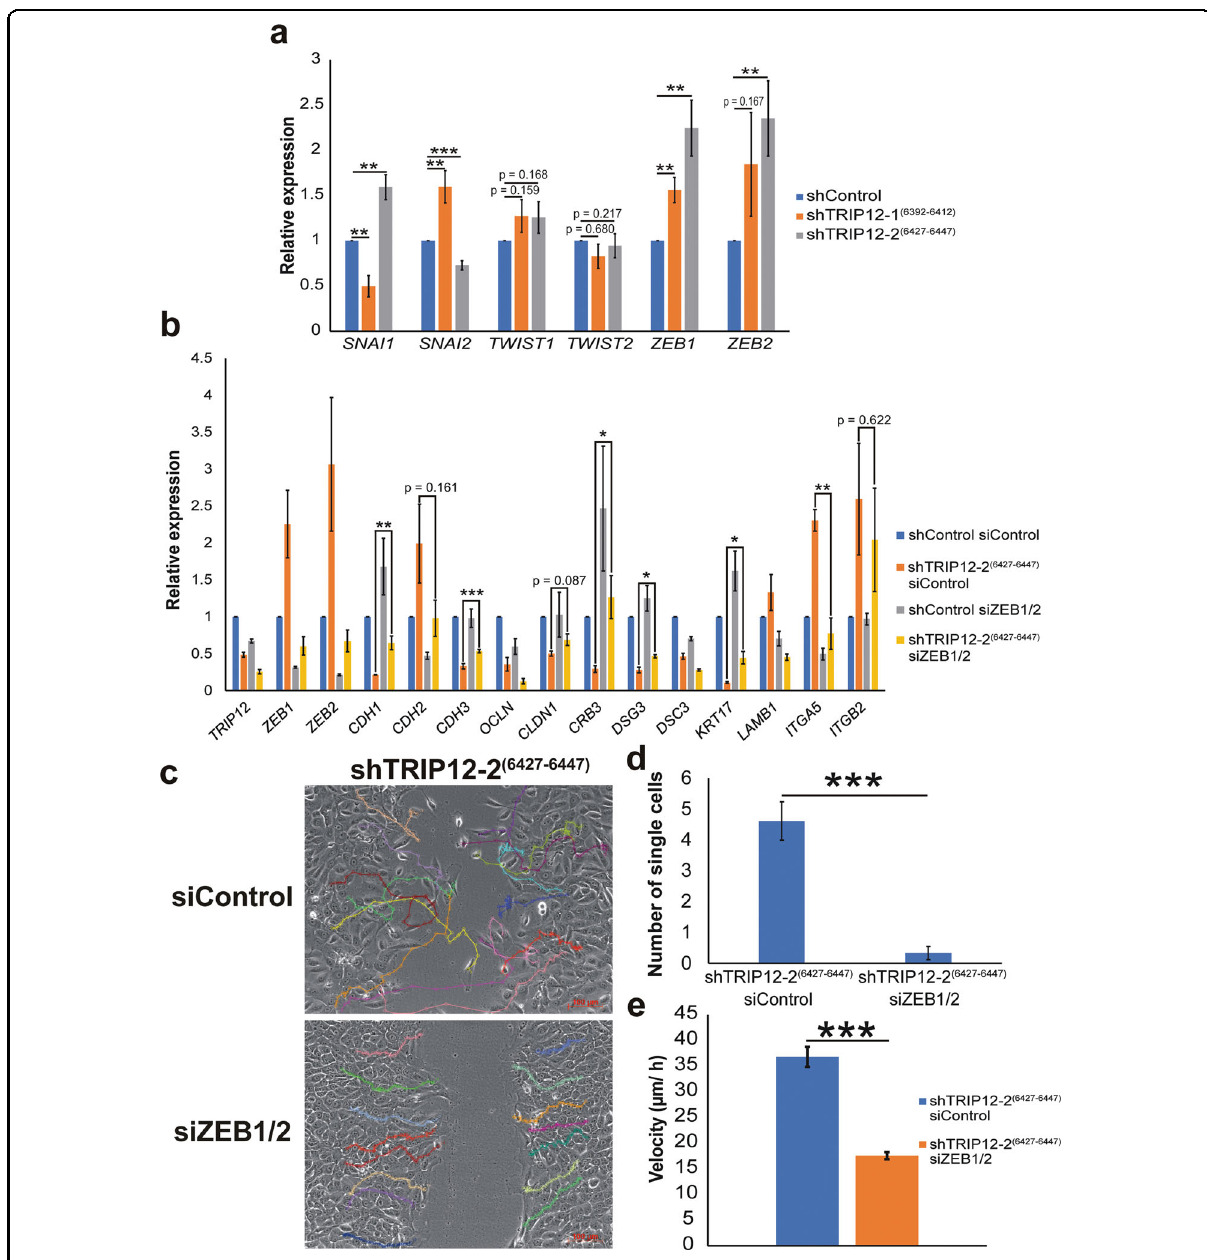
Fig. 5 TRIP12 inhibits ZEB1/2 gene expression to regulate EMT and cellular behavior. a Relative expression of the mRNA levels of EMT transcription factors in MCF10A cells stably depleted of TRIP12. Relative expression levels were normalized to Actin mRNA levels and data quanti fi ed relative to shControl. ( N = 7). Data represent means ± SEM. ** p value < 0.01; *** p value < 0.001. b Relative expression of the mRNA levels of EMT markers in MCF10A cells stably depleted of TRIP12 and with ZEB1/2 depletion. Relative expression levels were normalized to Actin mRNA levels and data quanti fi ed relative to shControl siControl. ( N = 3). Data represent means ± SEM. * p value < 0.05; ** p value < 0.01; *** p value < 0.001. c Representative cell tracking snapshot images of cell migration/ wound-healing assay for MCF10A shTRIP12-2 (6427 – 6447) , with either siControl or siZEB1/ 2, at midpoint to wound closure. Fifteen single cell tracks are represented with different colors in each image. Images were taken at 10X magni fi cation. The scale bar at the bottom right corner = 100 µm. d Quanti fi cation of the number of single cells in the remaining wound area from images when the remaining wound area is 35 – 45% of the total area. ( N = 5). Data represent means ± SEM. ***, p value < 0.001. e Velocity of tracked MCF10A shTRIP12-2 (6427 – 6447) siControl and siZEB1/2 cells. Fifteen cell tracks per condition were used for acquiring velocity data. Data represent means ± SEM. *** p value <